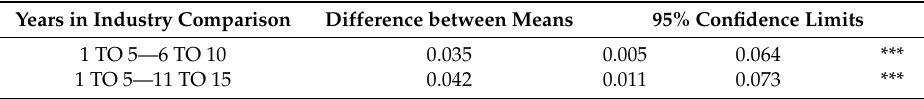
Table 5. t Tests: Least Significant Difference (LSD) for SCS and years in industry.